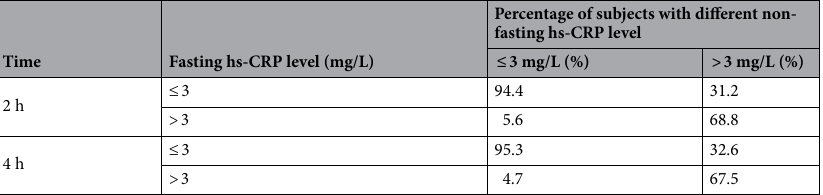
Table 2. Source analysis of patients with different hs-CRP levels in the non-fasting state. Data were the percentage of CHD patients with non-fasting hs-CRP levels ≤ 3 mg/L or not after a daily meal deriving from those with different levels of fasting hs-CRP.